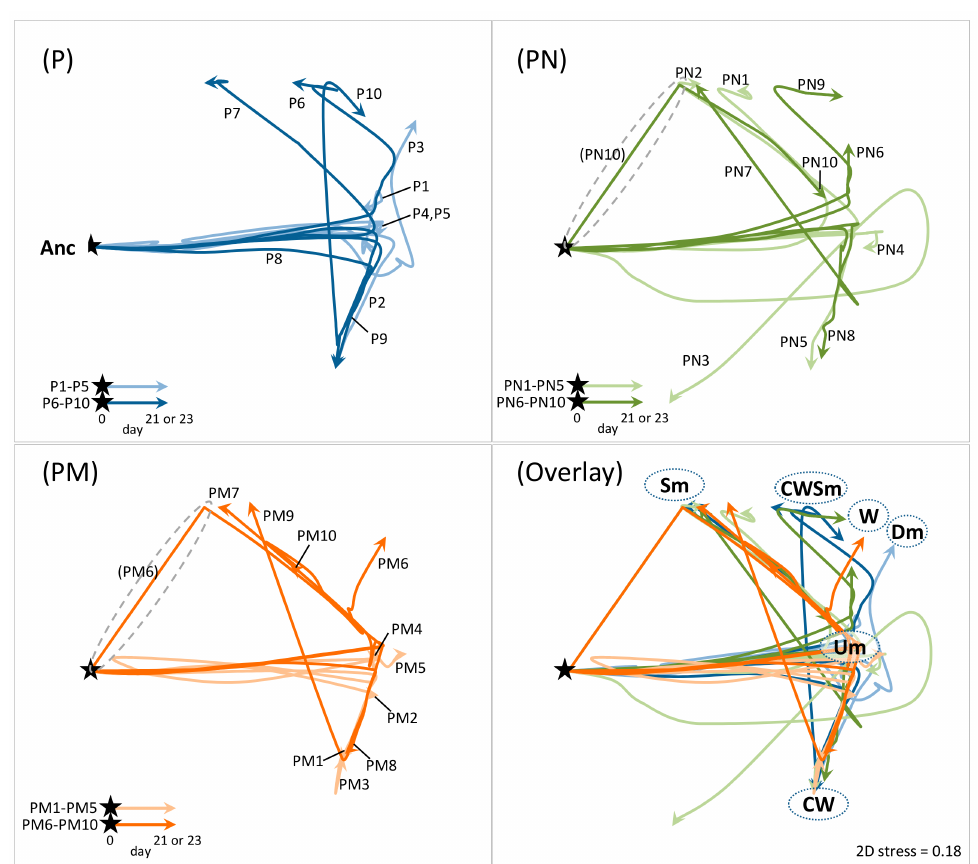
Figure 4. Temporal trajectories of P. aeruginosa population structure. 2D non-metric multidimensional scaling (nMDS) plot was created based on community resemblance (Bray–Curtis similarity) matrix generated from time course data of abundance of ancestor and CMVs in each culture shown in Figure 1b (see Material and Methods). Each arrow line corresponds to each culture line in Figure 1b (ten lines each for the PAO1 pure culture [P], the coculture with S. aureus Newman [PN], and the coculture with S. aureus Mu50 [PM]). Filled stars indicate starting point (time zero; 100% ancestor), and trajectories of arrow line represent the transition of population structure. The more positions in the 2D pane are closed to each other, the more population structures are similar. Name of CMVs on the plot indicates a position of the culture whose population was almost fully predominated by indicated CMVs. Grey dashed circles highlight trajectories observed specifically in the coculture with S. aureus